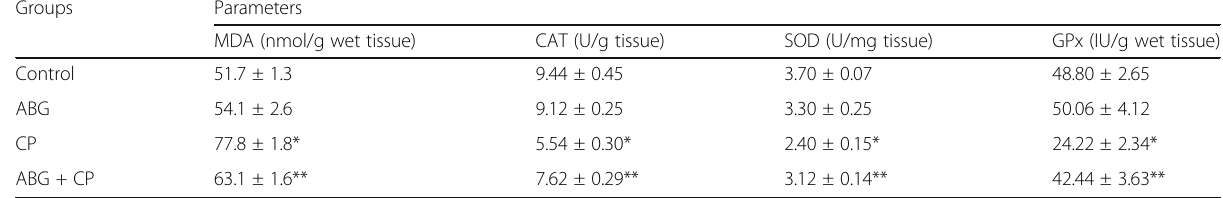
Table 3 Ameliorative effect of aged black garlic (ABG) on some oxidative stress parameters of the cyclophosphamide (CP)-treated rats